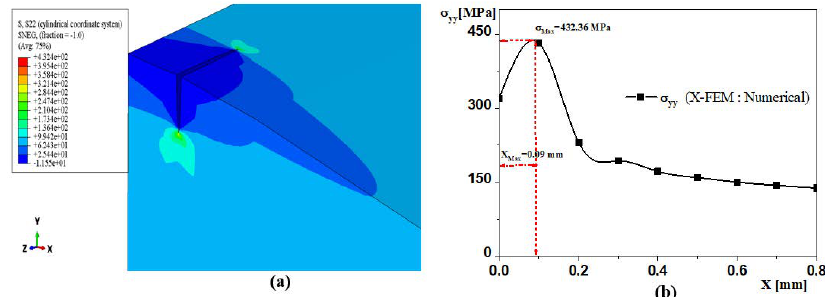
Figure 5. The distribution of the elastoplastic circumferential stress ahead of the defect: ( a ) Result of the simulation by the XFEM technique; ( b ) the curve of σ yy .